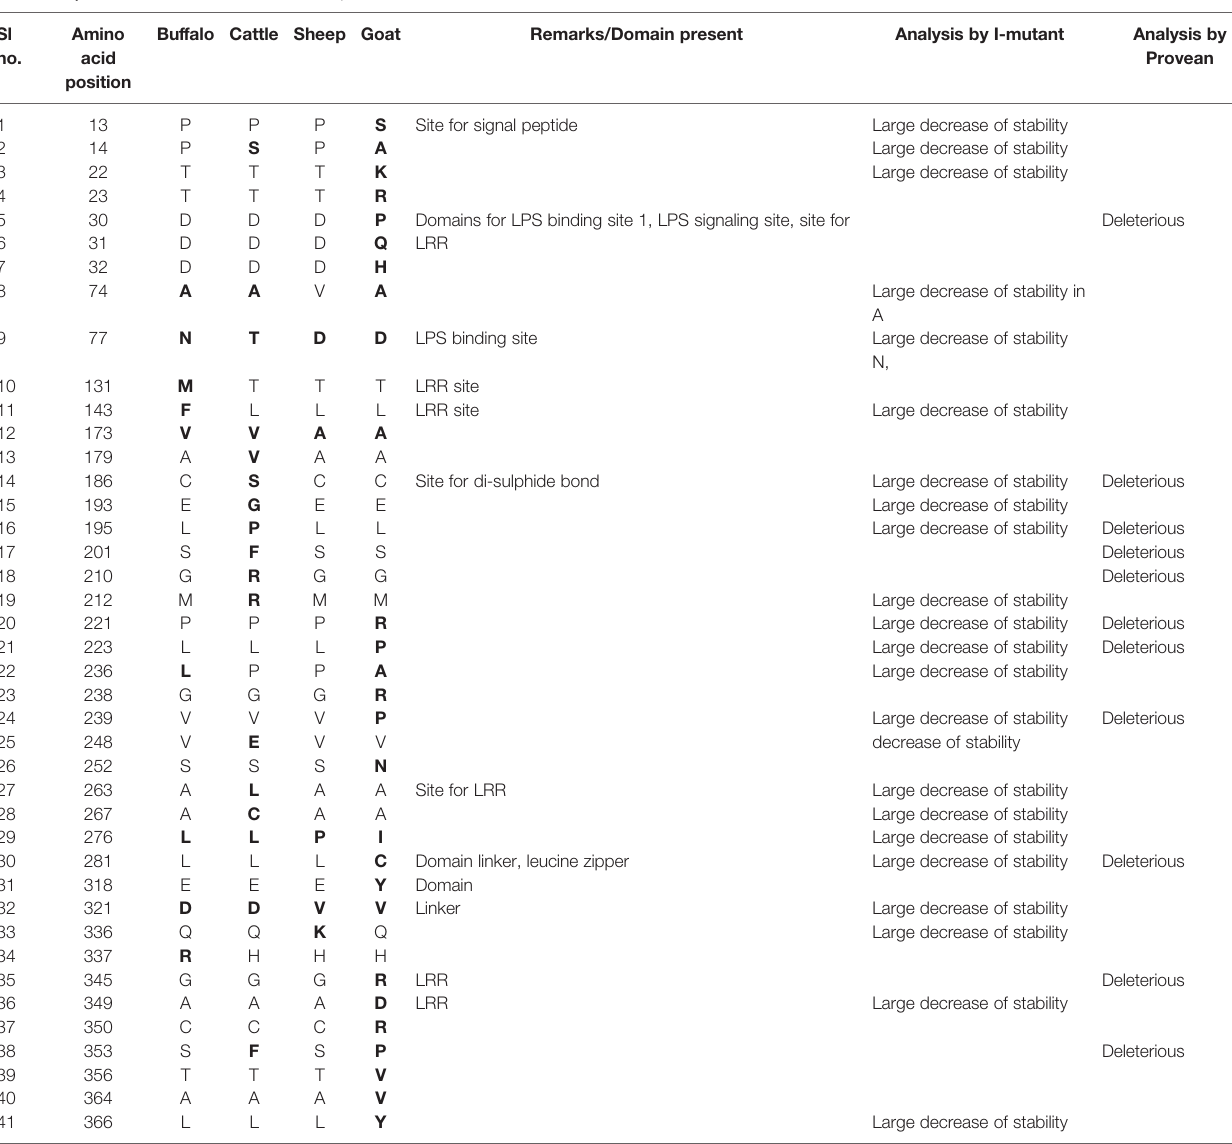
TABLE 1 | Amino acid variations in different species of ruminants.